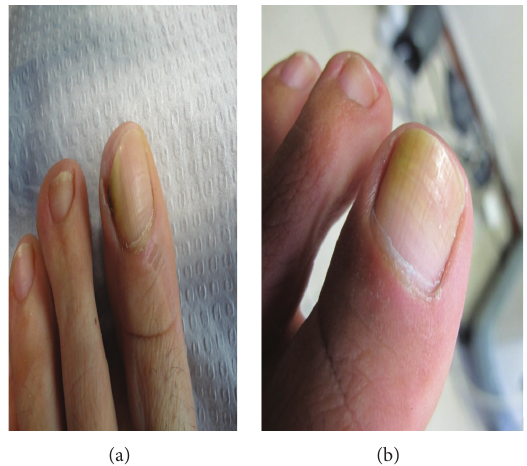
Figure 3: (a) 48-year-old female patient before treatment . Trichophyton rubrum was isolated on mycological testing. OSI was 9. (b) After treatment with great improvement. OSI is 2, showing 77.78%